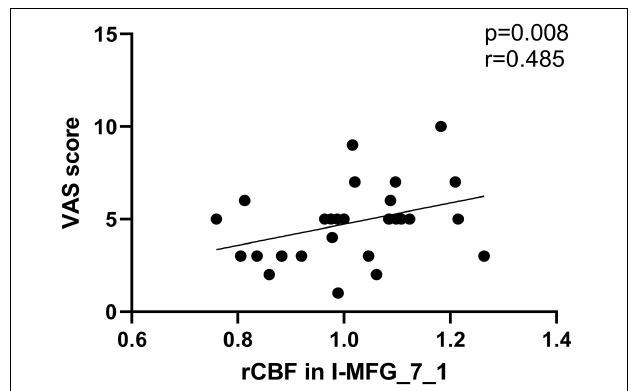
FIGURE 7 | The significant correlations between the CBF changes and the clinical data in unilateral SSNHL patients. CBF in ipsilateral MFG_7_1 of SSNHL patients was positively correlated with VAS score ( r = 0.485, p =